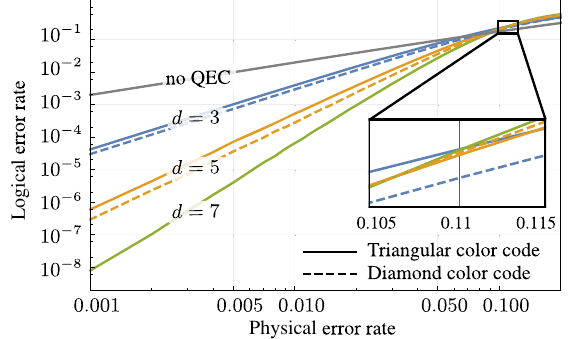
FIG. 19. Logical error rate as a function of physical error rate obtained from Monte Carlo simulation with a lookup table decoder for triangular (solid line) and diamond (dashed line) color codes with code distances d ¼ 3 and d ¼ 5 , and for the triangular color code with d ¼ 7 . The sample size is between 10 7 and 10 10 trials for data point corresponding to high and low logical error rates, respectively. The upper line show the logical error rate without quantum error correction. The inset zooms into ∼ 11% the crossover region around p phys